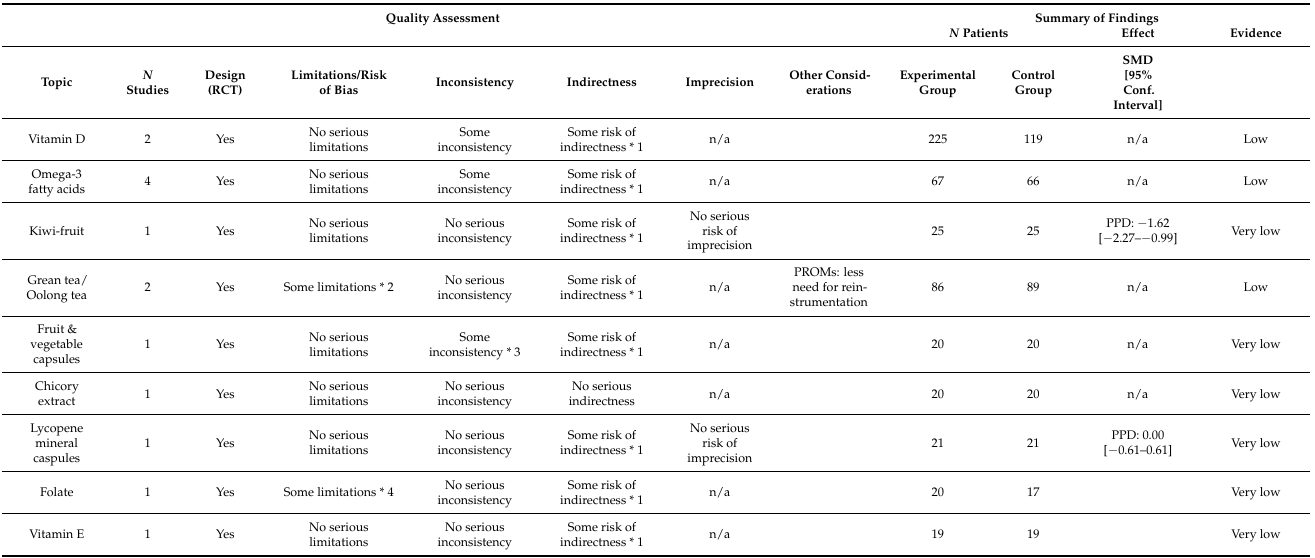
Table 2. Grading of Recommendations Assessment, Development and Evaluation (GRADE) accord- ing to Schünemann